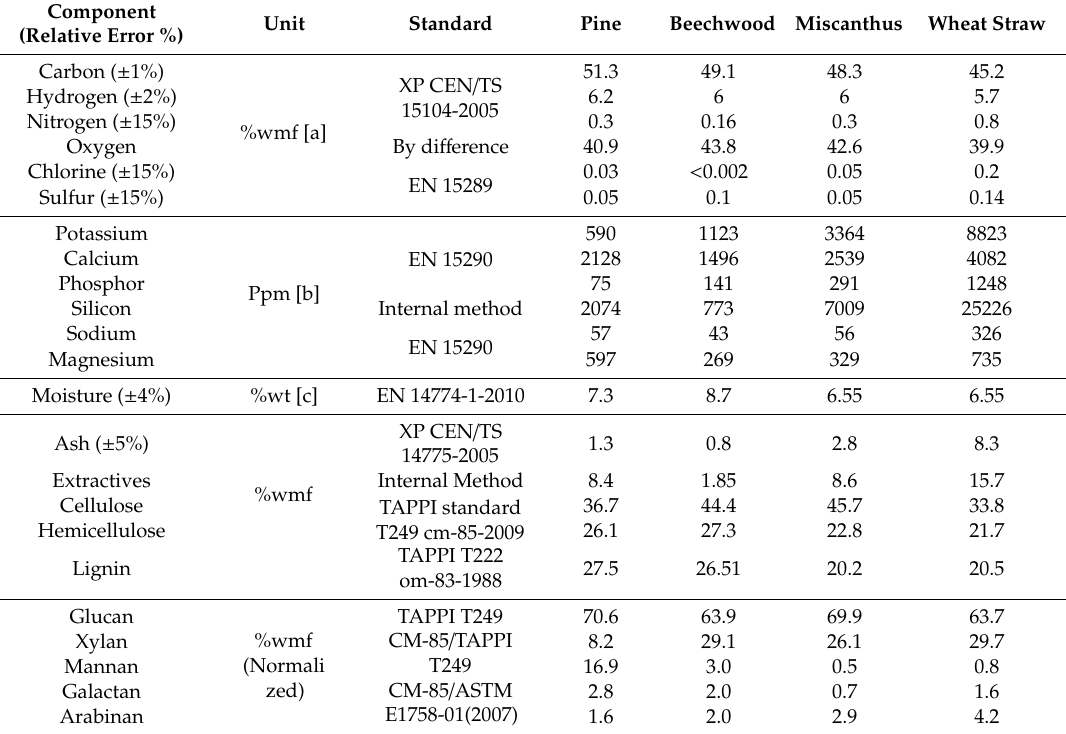
Table 1. Elemental and macromolecular composition of raw biomasses.